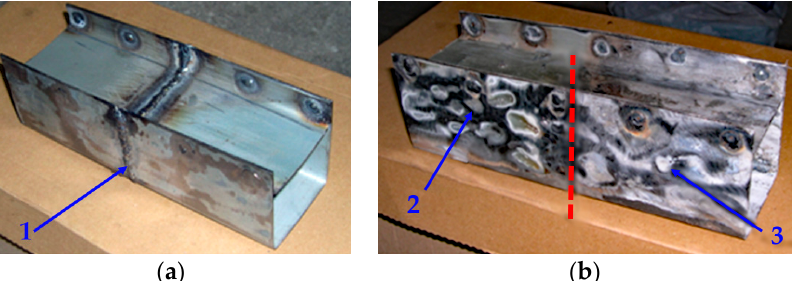
Figure 10. Specimens simulating the properties of longitudinal member restored after a traffic acci- dent: transversely cut and welded at the centre ( a ); made of the material hardened by plastic defor- mation and annealed ( b ) (1—weld; 2—part of specimen made of the plastically strained material; 3—part of specimen made of annealed material).